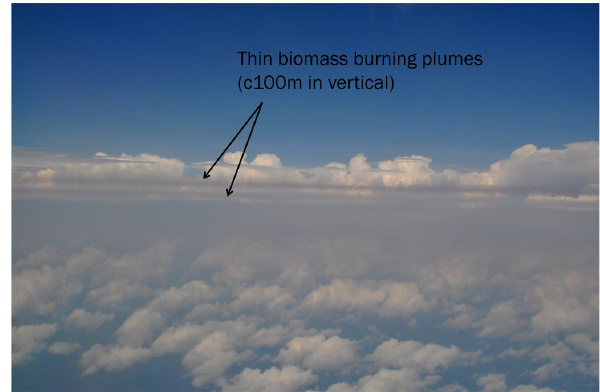
Fig. 8. A photograph (c/o Steve Andrews) from the BAe-146 at ca. 7km altitude during BORTAS-B (flight B624, 21 July 2011) illus- trating the thin filaments of pyrogenic outflow.